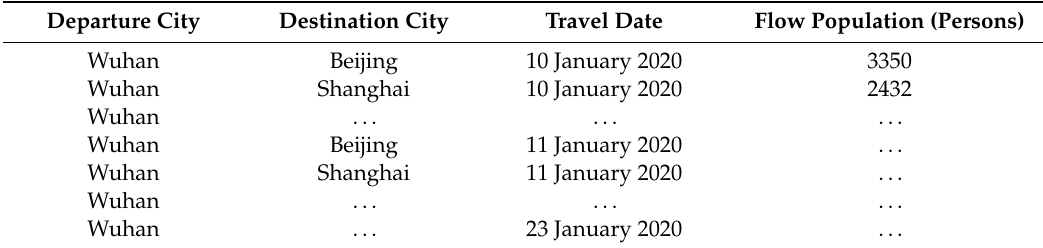
Table 1. Raw dataset of mobile internet positioning